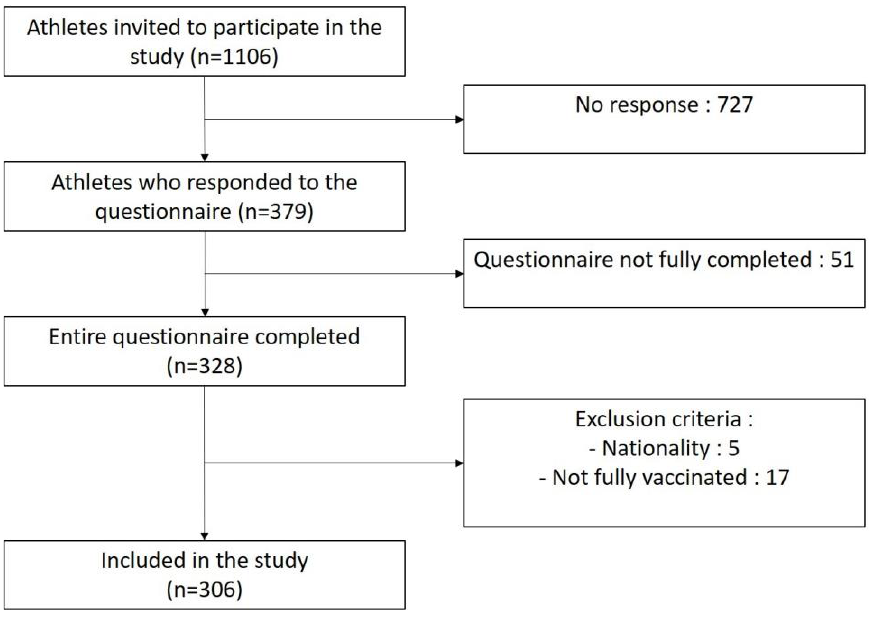
Figure 1. Study flowchart. Table 1. Sociodemographic and COVID-19 vaccination characteristics of the included population of elite athletes ( n = 306).